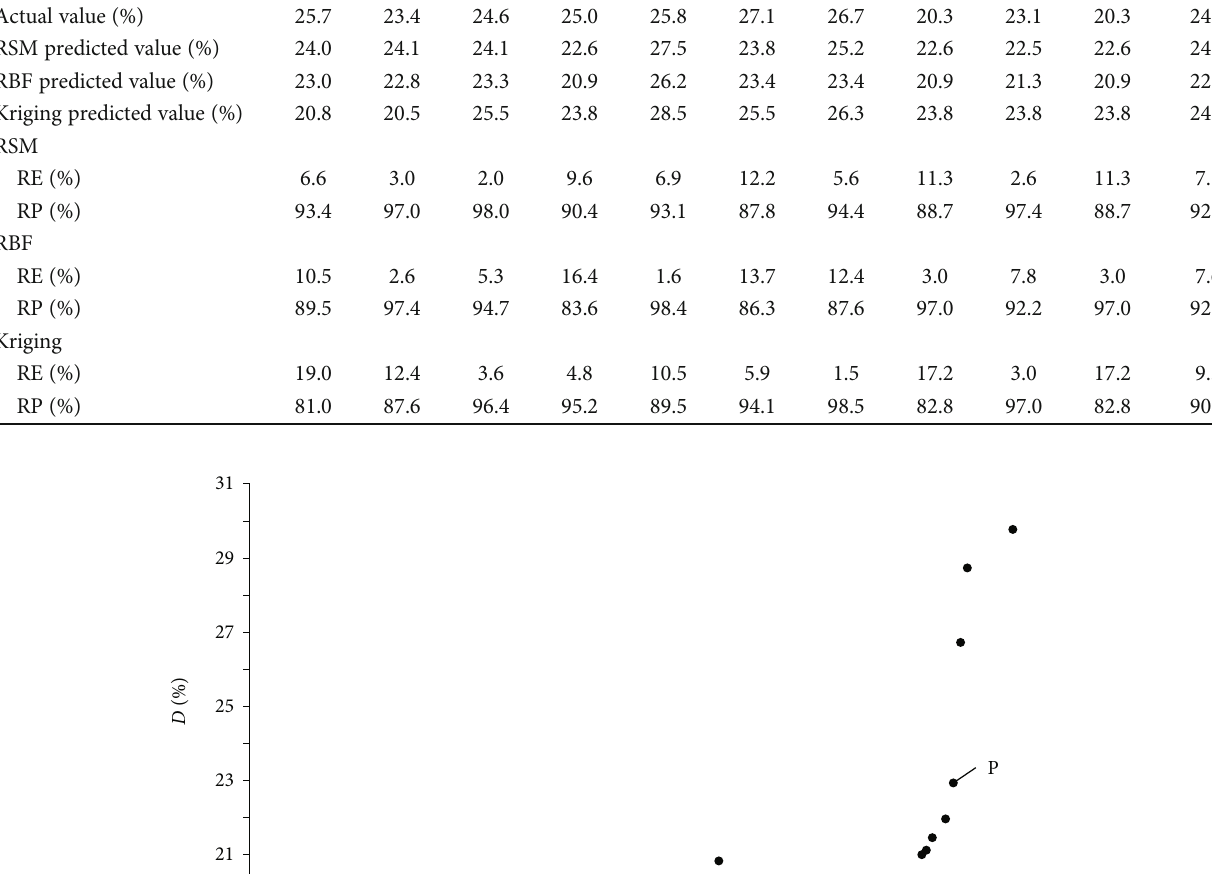
Table 3: The actual value, predicted value, RE, and RP of wall thickness di ff erence of the three models. Sample 1